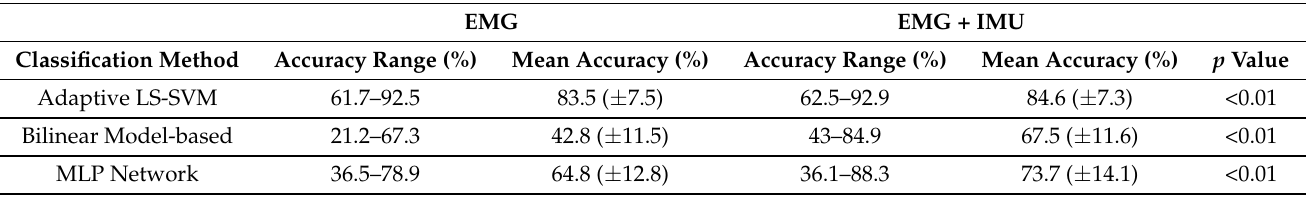
Table 2. Pairwise comparison of the EMG, and EMG and IMU datasets for each classification method. The p value represents the significance level of the pairwise comparison between the mean recognition accuracy of the sensor modalities on a specific classification model. Numbers in brackets represent the standard